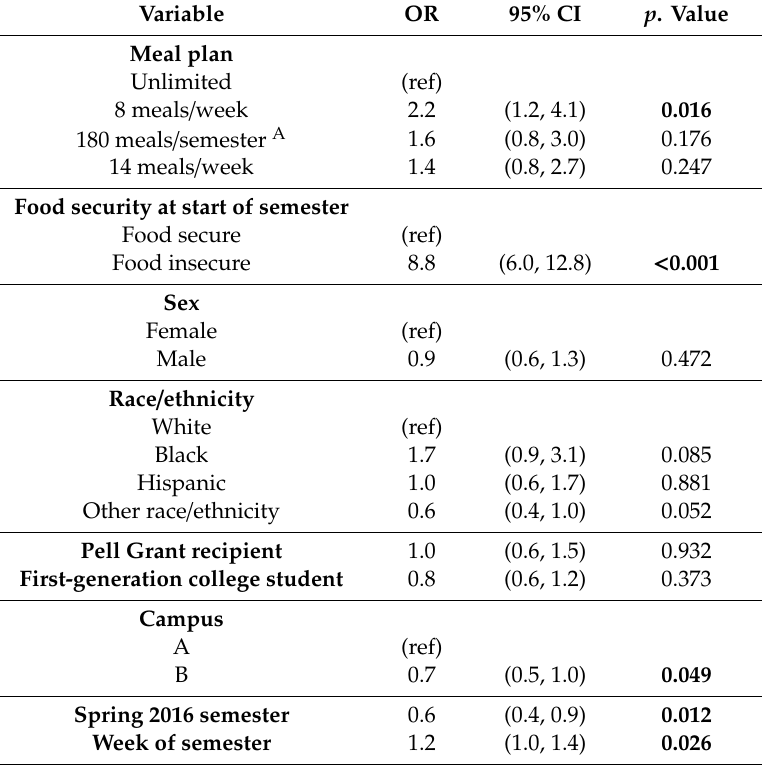
Table 3. Results of the logistic generalized estimating equation (GEE) examining food insecurity at the end of the semester by sociodemographics and meal plan ( n = 534 participants, 794 data points).